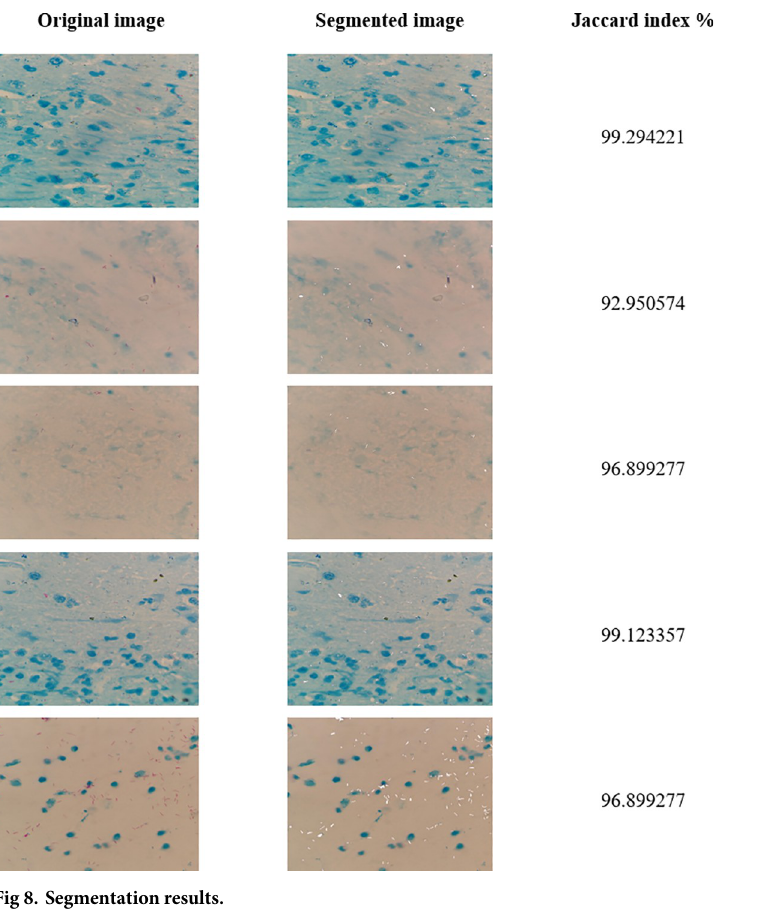
Fig 8. Segmentation results.